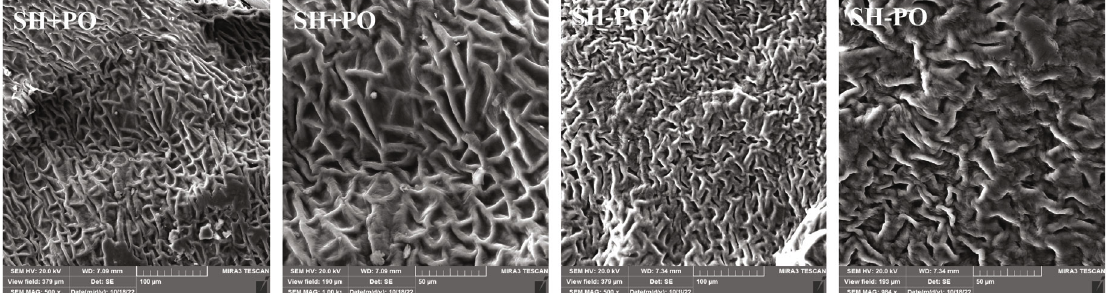
Figure 2: FE-SEM microphotographs of SH+PO and SH-PO (di ff erent magni fi cations).